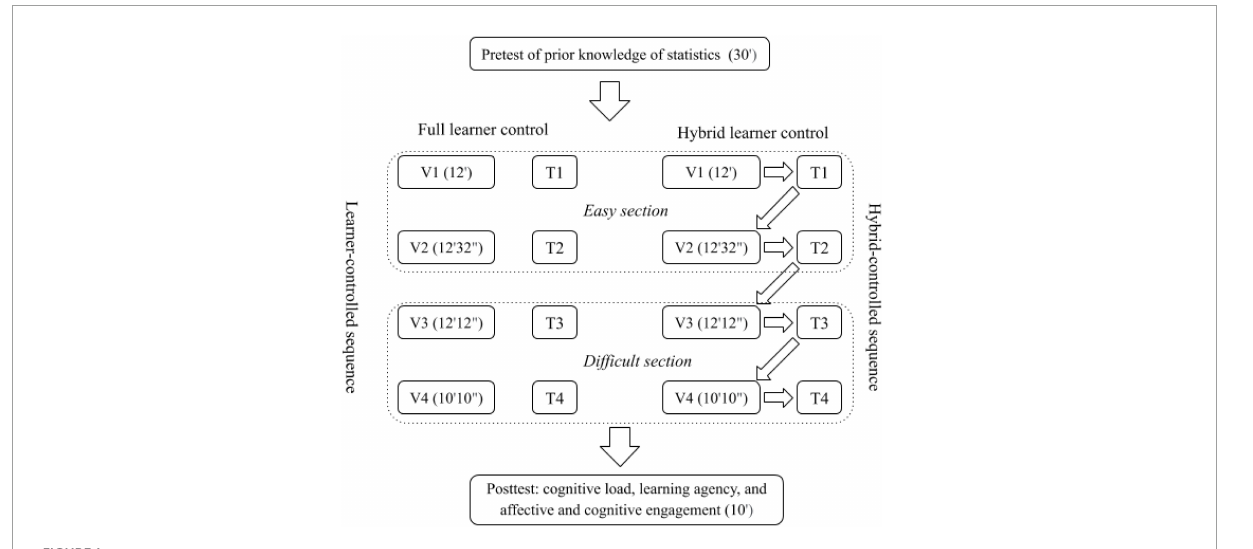
FIGURE1 Procedure of this study. V, Video; T, Test; ’Minute; “Second.